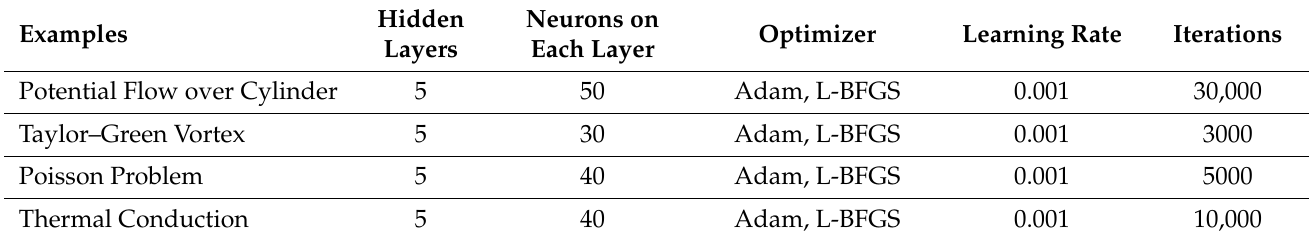
Table 2. Designed neural network architectures for different working